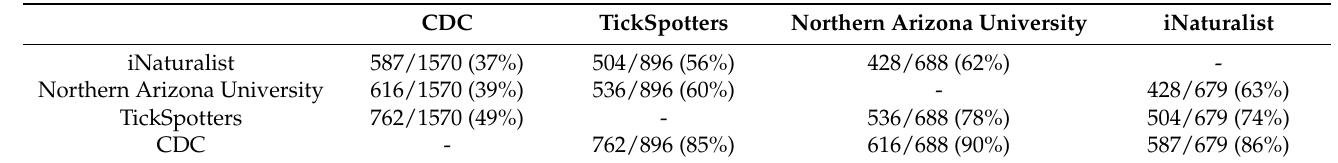
Table 3. Overlap of counties with reports of I. scapularis between various US tick surveillance data sources. County-by-county comparison data are available in Table S3.